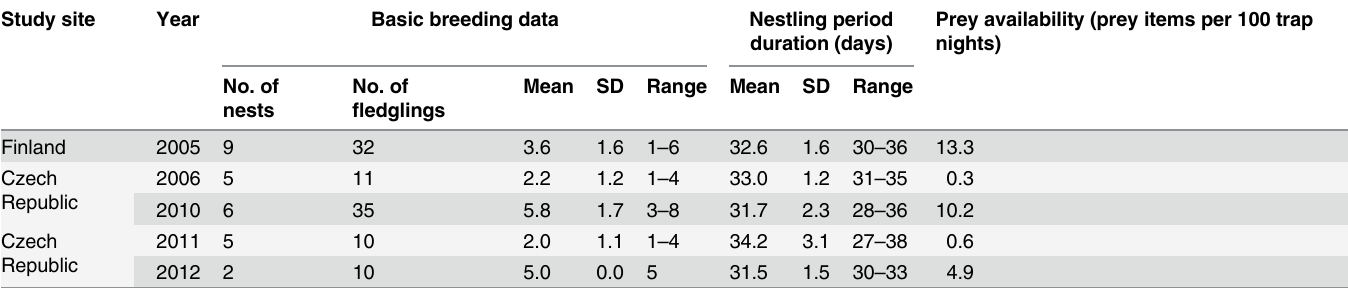
Table 1. Basic breeding data of both studied populations, individual duration of nestling period, and prey availability in both study sites and all study years. Study site